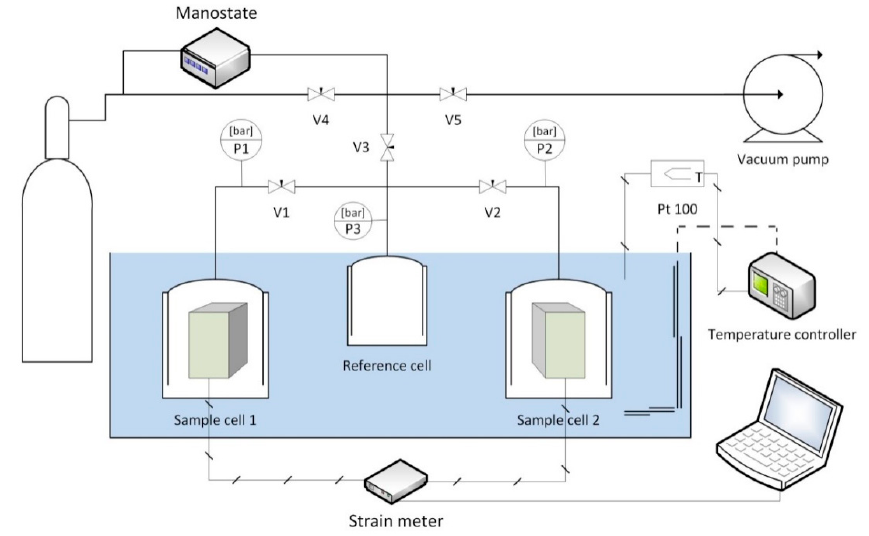
Figure 1. Schematic diagram of the apparatus.